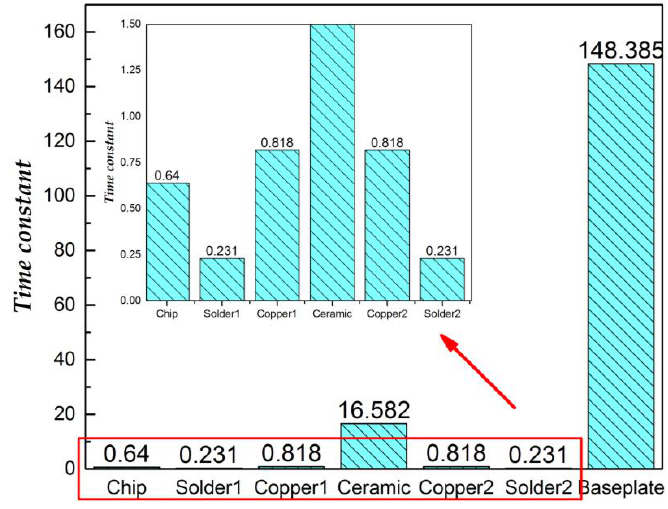
Figure 5. Time constant of each layer.